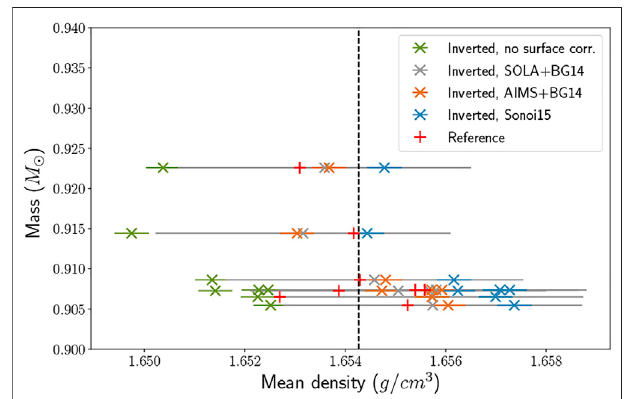
FIGURE 7 | Effect of surface corrections and model-dependency on meandensity inversions ofKepler 93[adapted from Bétriseyet al.(2022)] as a function of mass of the reference model. Red crosses show the reference mean density values, olive green crosses show results without surface corrections, blue and grey crosses show results using the Sonoi et al. (2015) and Ball and Gizon (2014) corrections in the SOLA cost function, whereas brown crosses show results using coef fi cients extracted from MCMC modelling and applied